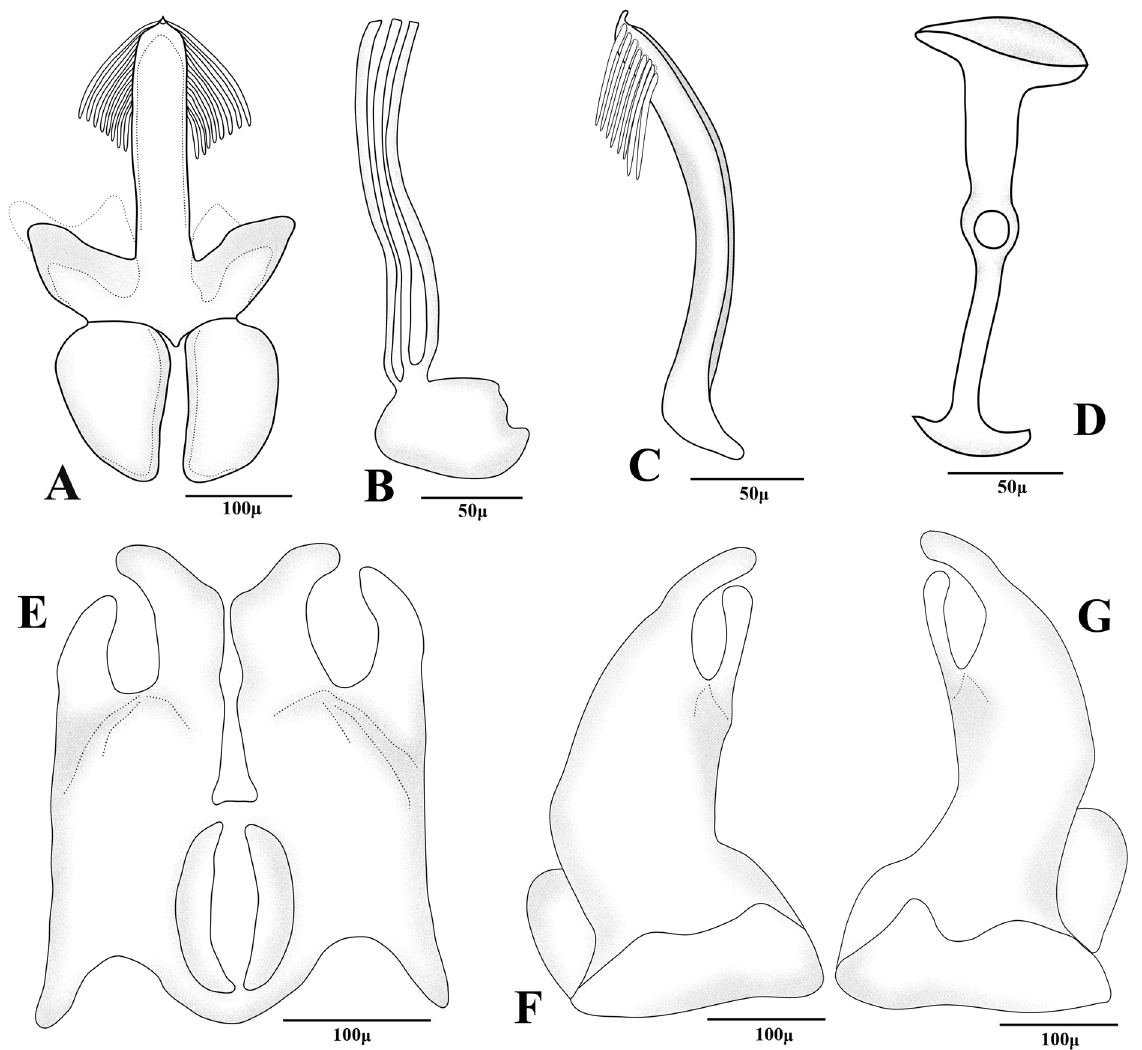
Fig. 3. Terminalia of Dasydorylas derafshani Motamedinia & Kehlmaier s p. nov., ♂, paratype. A . Phallic guide, gonopods and hypandrium in ventral view. B . Phallus and membranous sheet in lateral view. C . Phallic guide in lateral view. D . Ejaculatory apodeme. E . Surstyli in dorsal view. F . Left surstylus in lateral view. G . Right surstylus in lateral